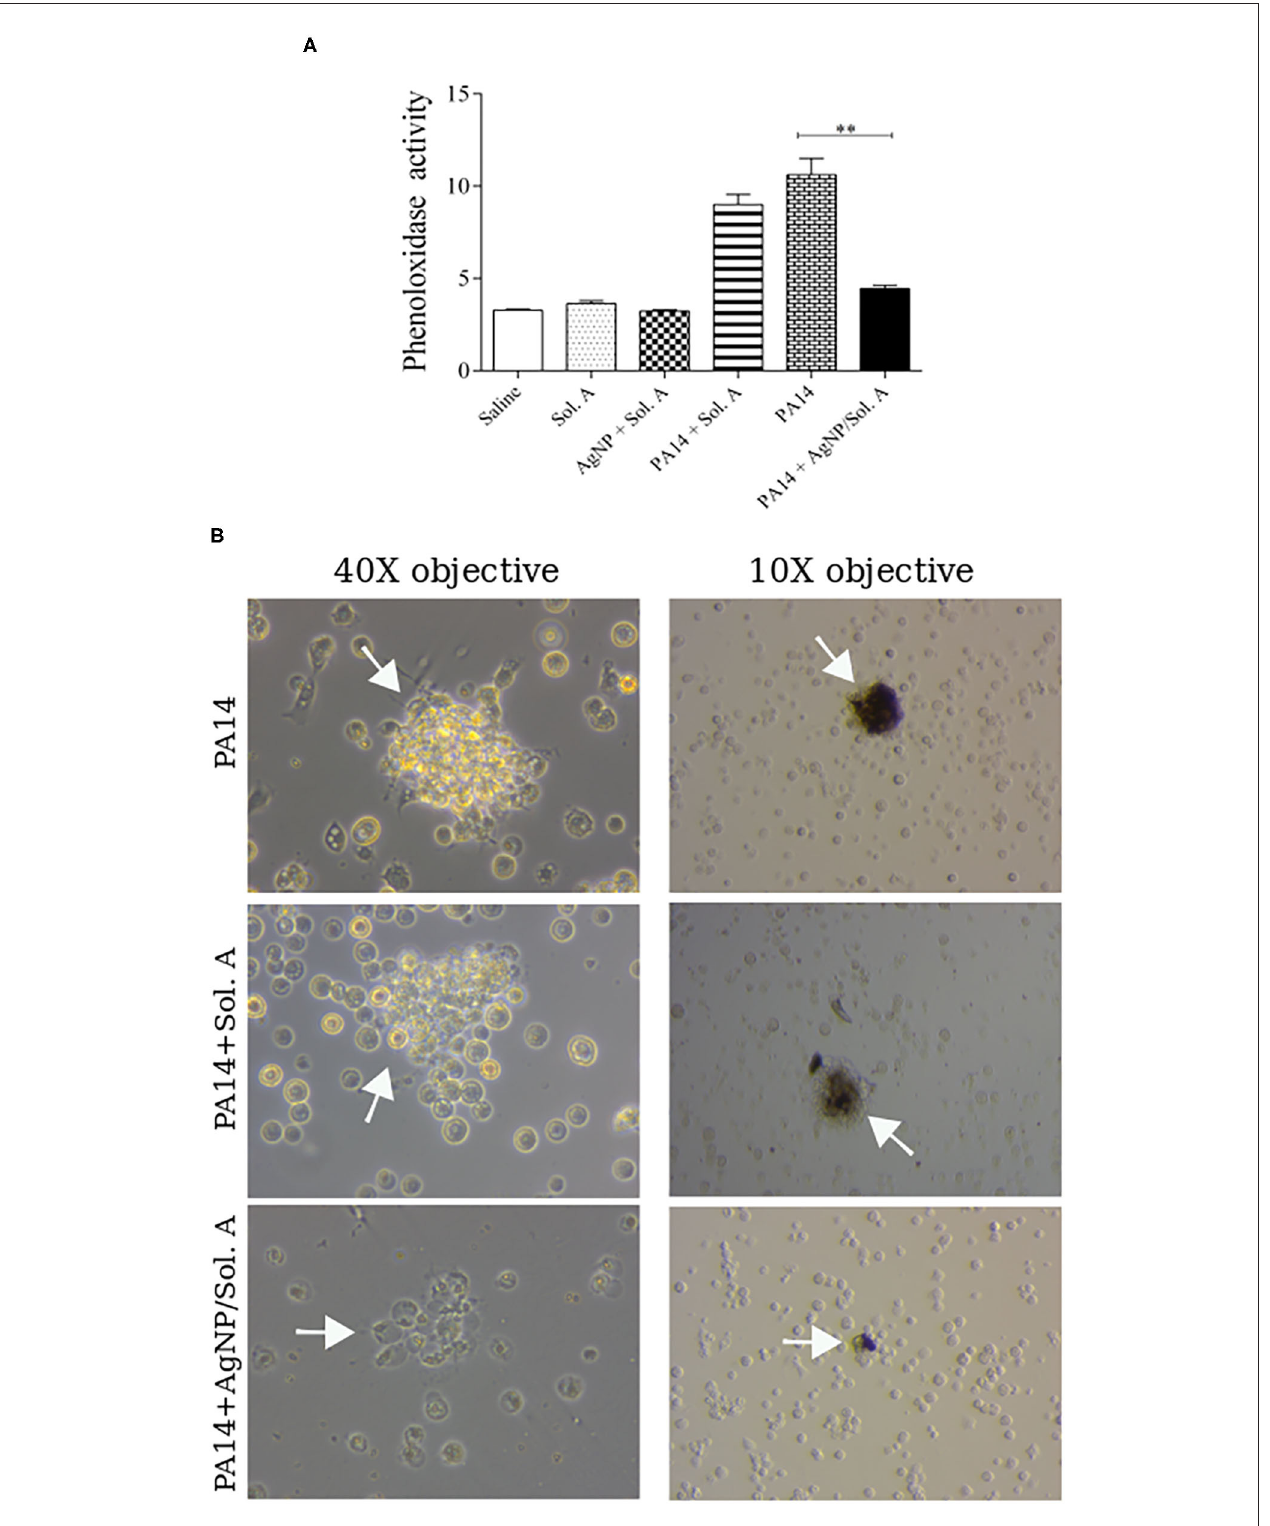
FIGURE 6 | (A) Phenoloxidase activity at 9 h following infection with P. aeruginosa was determined by analyzing the rate of melanization at 0, 15, 30, 45, 60, 75, and 90 min. The bars representations are as described in the legend of Figure 4 . Each bar represents the mean and standard deviations of three independent experiments. Each treatment condition contained 16 larvae . ** p = 0.0031 (ANOVA and RM ANOVA followed by t -test). (B) Microscope images showing cell aggregates on the left and black aggregates on the right (white arrows) resulting from PO activity.